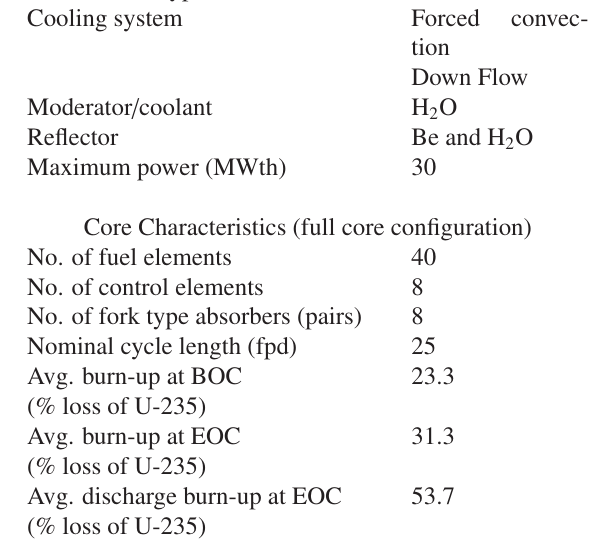
Figure 1. First criticality core configuration of RSG GAS first